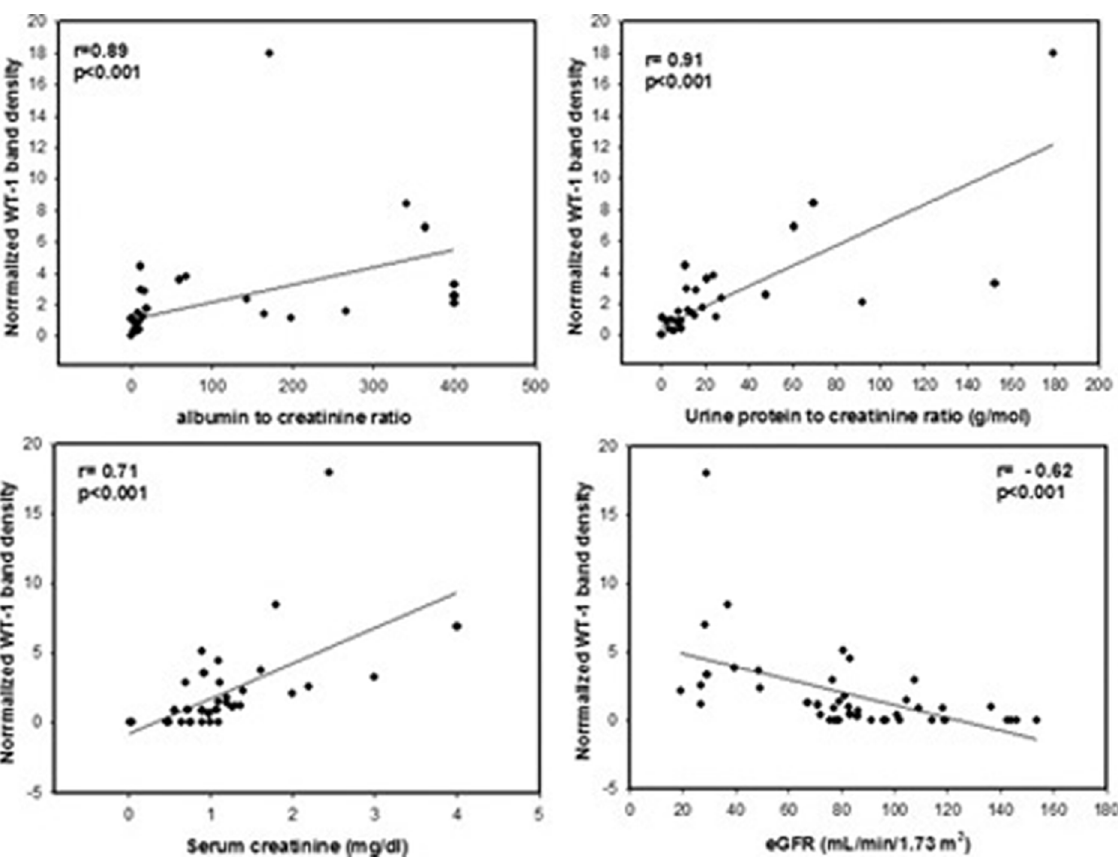
Figure 2. Relationship between urinary exosomal WT1 expression and parameters for renal function. Correlation of WT1 band density (normalized to TSG101 band density) with albumin to creatinine ratio (ACR); urine protein-to-creatinine ratio; serum creatinine; and estimated GFR in type-1 diabetic patients. Spearman rank-order correlation coefficient ‘r’ is given with its respective P-value, p , 0.05 was considered significant.